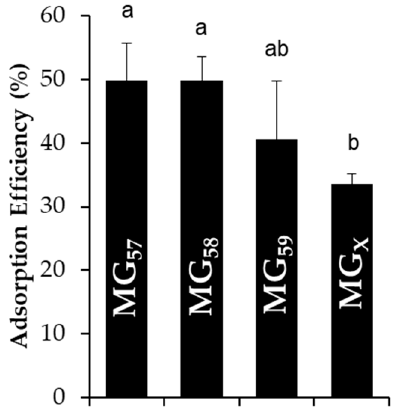
Figure 2. Effect of Blg microgel fabrication pH and cross-linking treatment on efficiency of microgel interfacial adsorption in limonene/corn oil-in-water emulsions. Letters above data denote groups that were not significantly different as a function of treatment.